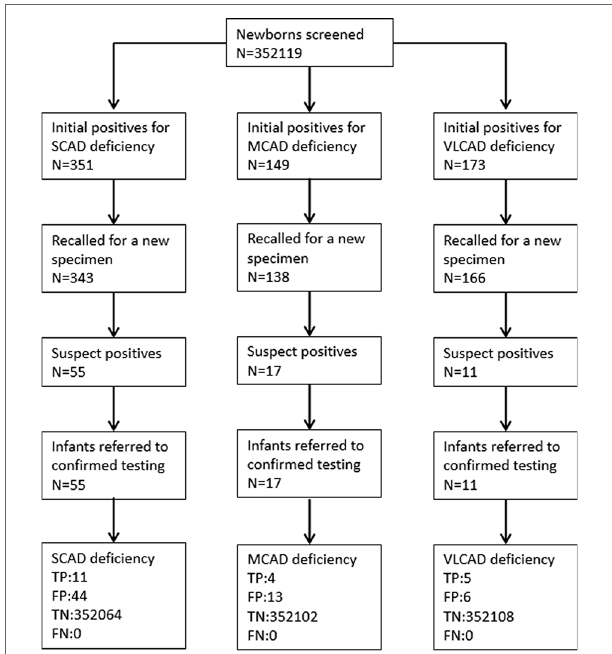
FIGURE 1 | Flowchart of expanded newborn screening for short, medium, and very long chain acyl-CoA dehydrogenase deficiencies. SCAD, short chain acyl-CoA dehydrogenase; MCAD, medium chain acyl-CoA dehydrogenase; VLCAD, very long chain acyl-CoA dehydrogenase; TP, true positive; FP, false positive; TN, true negative; FN, false negative.